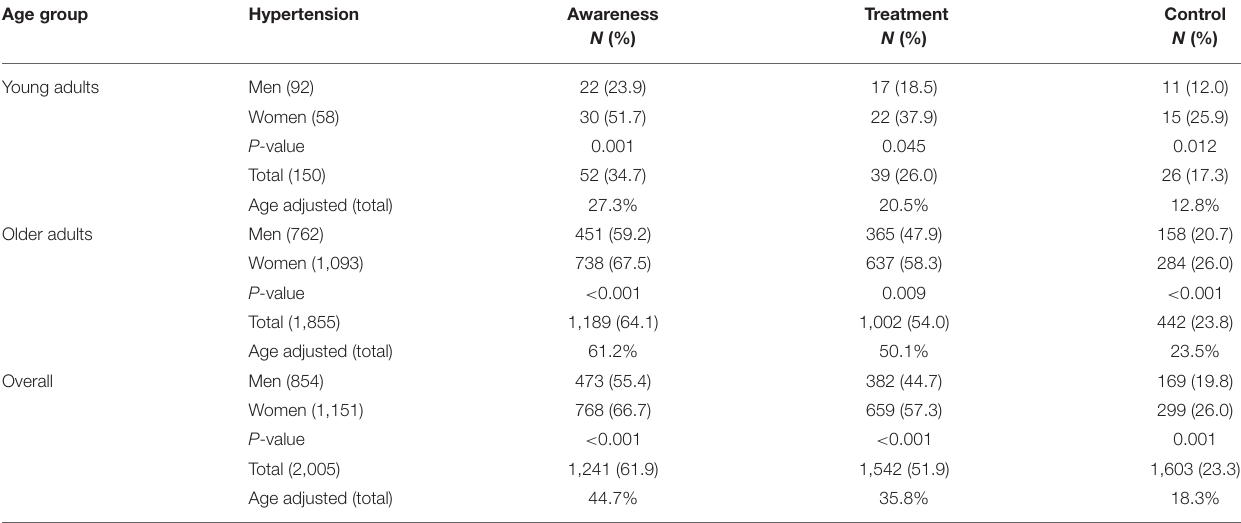
TABLE 4 | Awareness, treatment and control of hypertension among younger adults, older adults, and overall hypertensive population. Age group